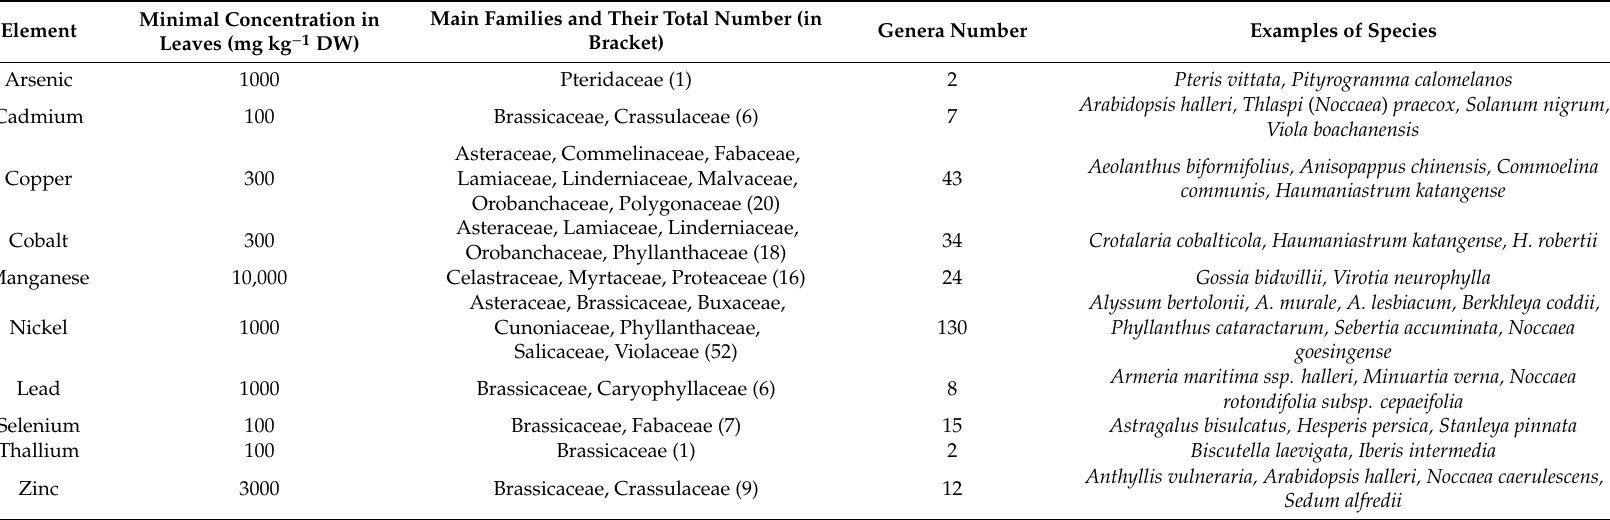
Table 2. Hyperaccumulating criteria for metallic elements (mg kg − 1 of leaf dry weight) according to van der Ent et al. [14], main families, the total number of genera and examples of representatives. Based on Rascio and Navarii-Izo [157]; Reeves et al.